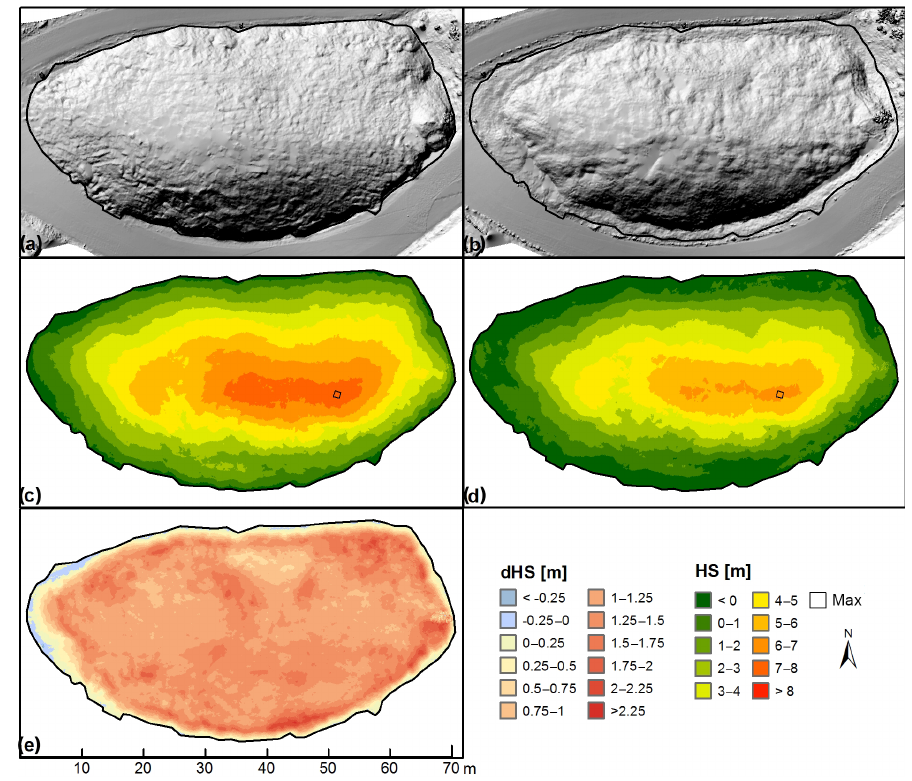
Figure 6. Martell snow heap: hillshade images from (a) 19 May and (b) 28 October, snow depth HS (c, d) and snow height change dHS (e) . Displayed are raw data that were not corrected for the remaining snow in the depot (c, d) and fresh snow at the surface (d, e) . The location of the maximum HS on 19 May is indicated in panels (c) and (d)